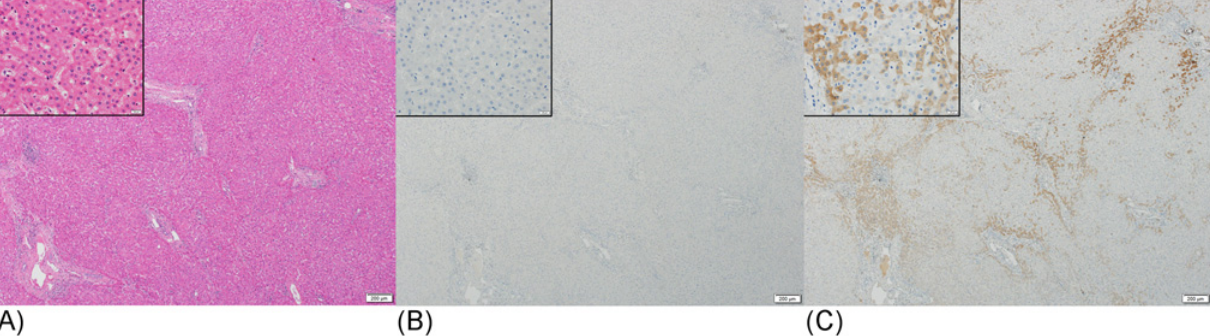
Fig 4. Immunostaining of DCP and NX-DCP in non-cancerous liver tissue. (A-C) Non-cancerous liver tissue showing scattered areas with strong NX- DCP expression, but no areas of DCP expression. HE stain (A), and immunostain for DCP (B) and NX-DCP (C).